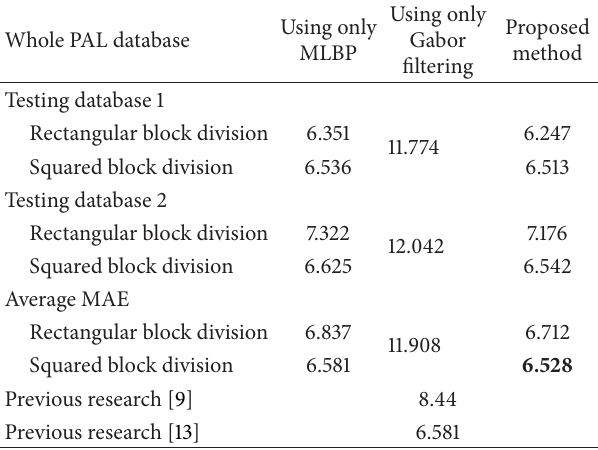
Table 2: The comparisons of MAEs using only MLBP, only Gabor filtering, and the proposed method combining the two methods (MLBP and Gabor filtering) (unit: years